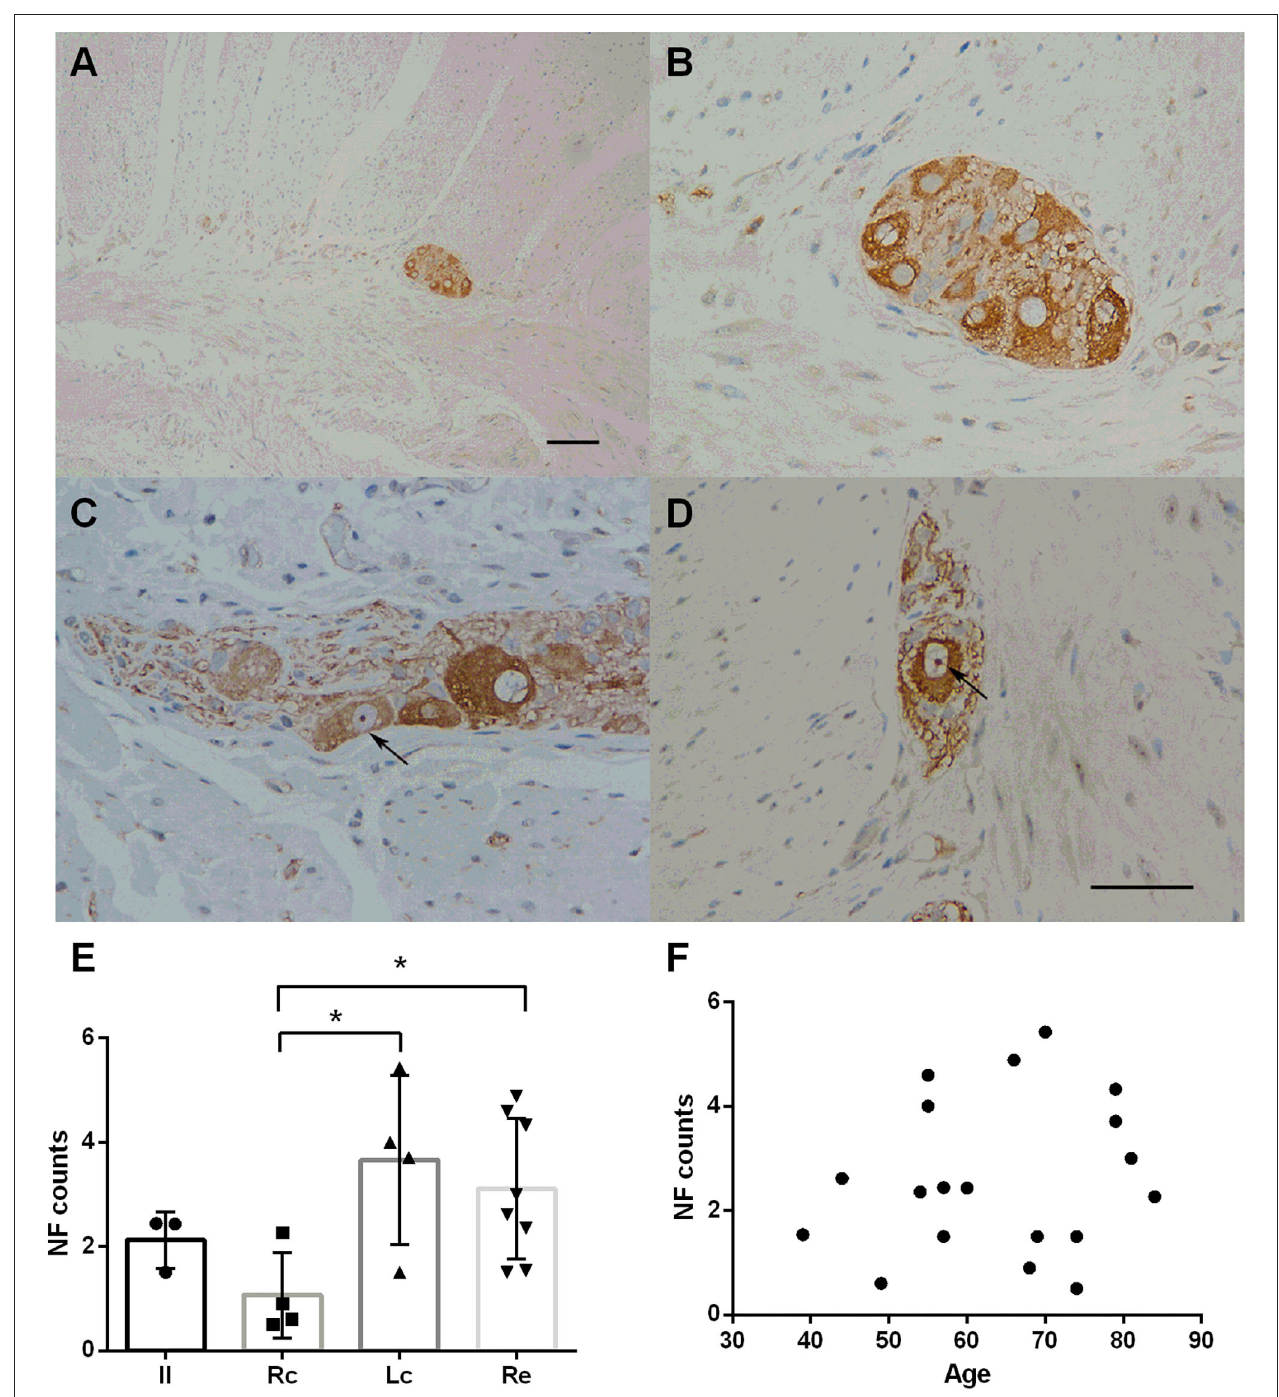
FIGURE 1 | Immunostaining of neurofilaments (NFs) in the myenteric plexus. (A–D) Immunostaining of NFs in the myenteric plexus. Representative image of the myenteric nerve plexus located between the two muscle layers (longitudinal and circular muscles), comprised of many nerve plexus sections on the cut surface (A) . Fine staining of NF-positive profiles (brown color) could be seen in the perikaryon of neurons in the myenteric plexus. The nuclei of the neurons were lightly stained and some nucleoli could be seen (black arrows in C,D ). Hematoxylin counterstain, scale bars = 100 µ m (A) , 50 µ m (B–D) . (E) Quantitative analysis of the NF-positive neuron count in the myenteric plexus. The count is subdivided into the ileum (Il), right colon (RC), left colon (LC), and rectum (RE). Inter-group differences are reported as per one-way ANOVA ( F = 3.564, df = 18, p = 0.040) followed by an LSD-t post-hoc test (RC group 1.07 ± 0.82 vs . the LC group 3.66 ± 0.62, p = 0.010; RC group 1.07 ± 0.82 vs. the RE group 3.11 ± 1.35, p = 0. 017). Data are shown as NF positive neurons per visual field for individual cases and the group mean ± SD is also shown. (F) Scatter plot of the NF-positive neuron count within the myenteric plexus with age. No significant correlation was observed (Pearson correlation, p = 0.499). * = p <